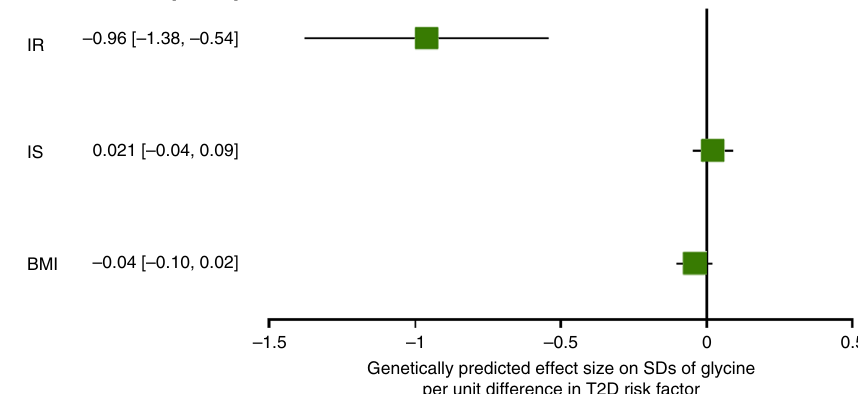
Fig. 9 Forest plot of the genetic effect sizes ± 95% con fi dence intervals of insulin resistance (IR), early-phase insulin secretion (IS) and body mass index (BMI) with glycine levels. Analyses were based on the inverse variance-weighted MR